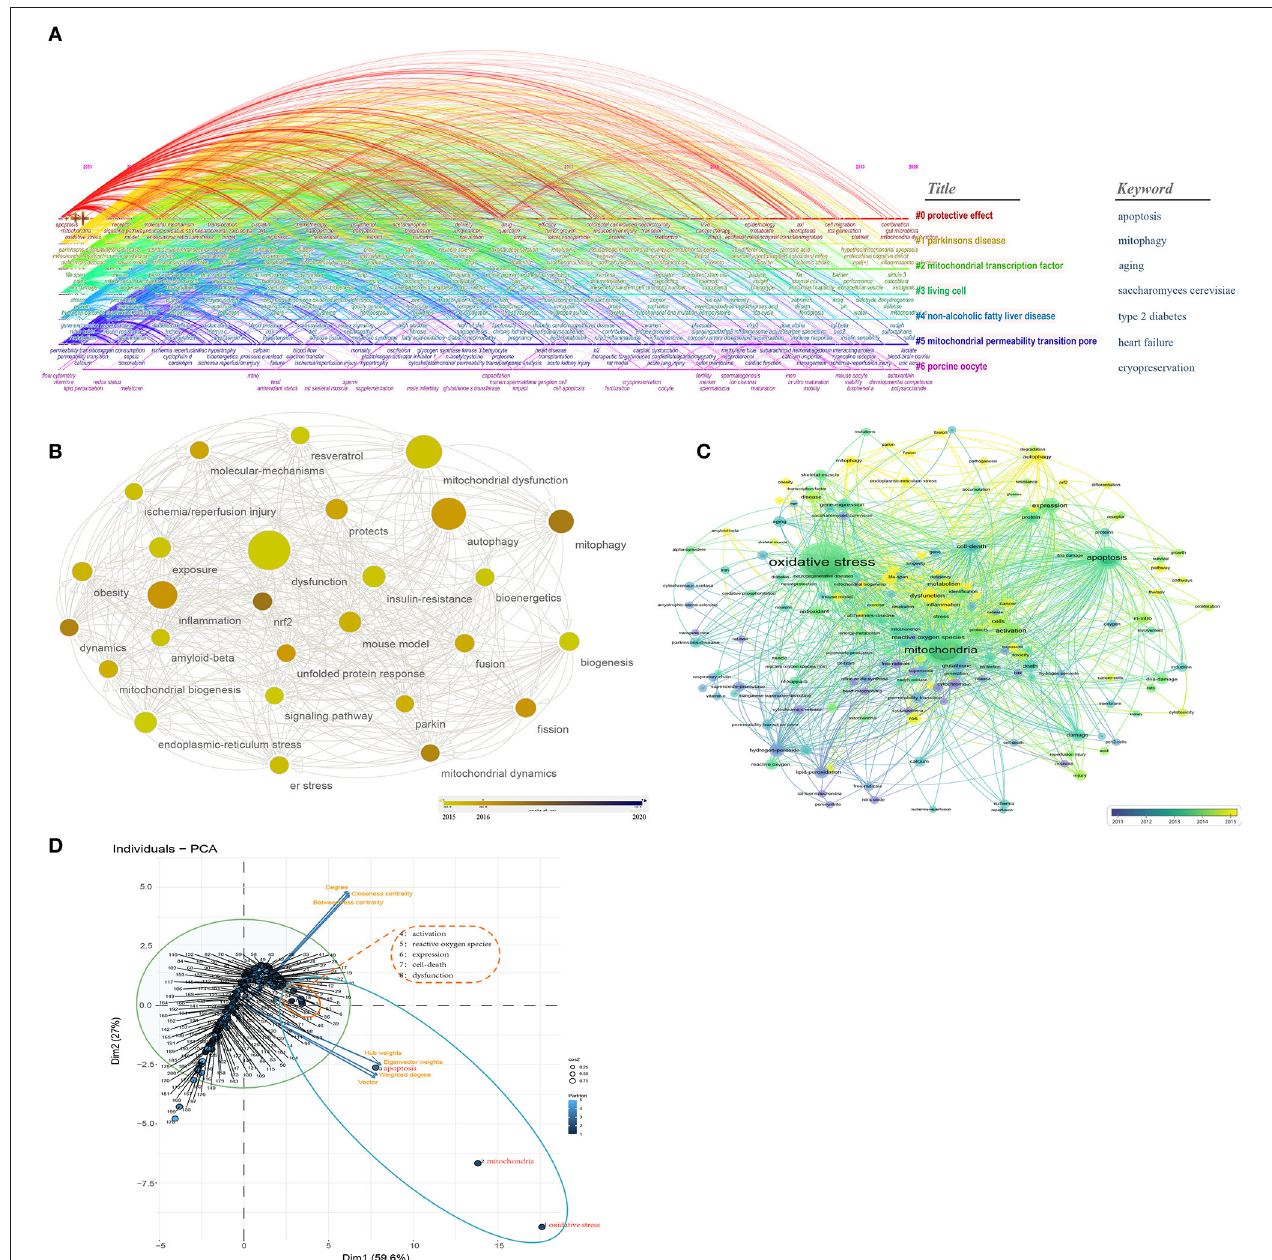
FIGURE 5 | Research hotspots and frontiers of “oxidative stress” AND “mitochondria” studies. (A) Time-based overlay (sub-network and cluster map) visualization based on “Title & Keywords”; (B) Analyze and visualize the research hotspots in recent years (2015–2020); (C) Co-occurrence analysis through VOSviewer; (D) PCA results of the analysis of the top 200 identified keywords provide highlights for the research programs. The blue circle represents high eigenvector centrality, and the orange circle represents both high closeness centrality and high eigenvector